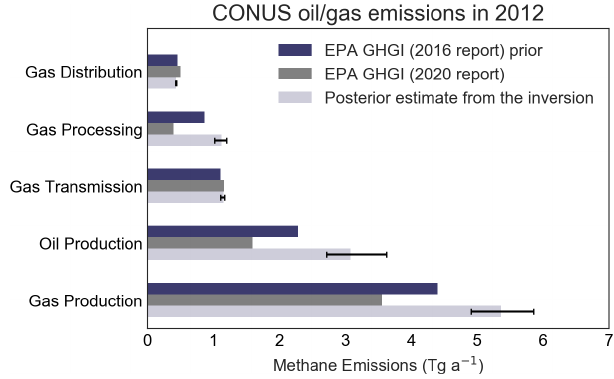
Figure 5. Methane emissions from the oil and gas sector in the con- tiguous US (CONUS) in 20212. The figure shows the original EPA GHGI estimates for 2012 used as a prior in the inversion (EPA, 2016), the updated EPA GHGI estimates for 2012 based on revised methodology (EPA, 2020), and the posterior results from the inver- sion. Horizontal bars give the ranges of the inversion